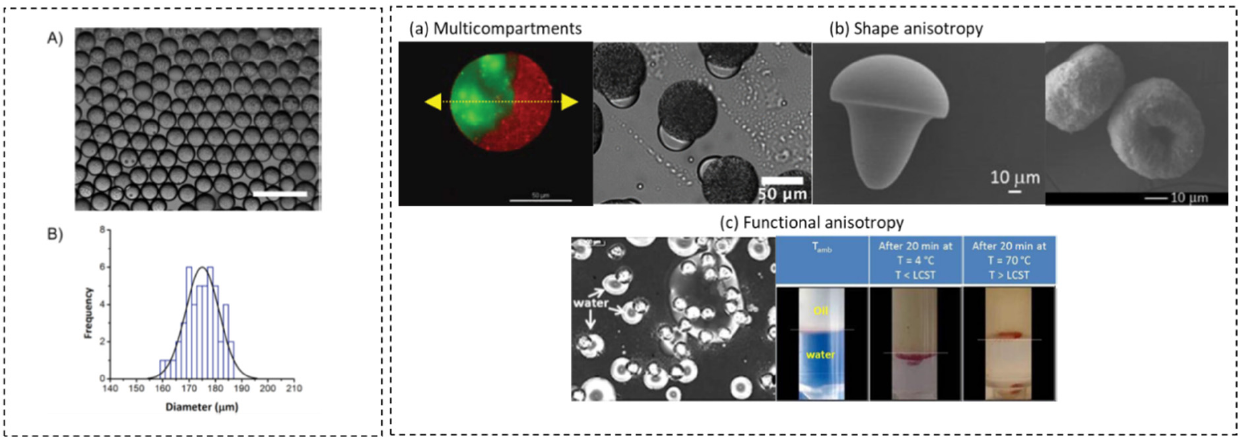
Figure 4. Control of the shape, size, and composition of microparticles and microcapsules produced by droplet microfluidics. ( A , B ) Size distribution of agarose-gelatin microgels obtained by the control of the flow rates in a flow-focusing device, adapted with permission from [43]. Copyright (2014) American Chemical Society. ( a ) Multicompartment and ( b ) anisotropic microparticles with Janus, mushroom, or doughnut morphologies and amphiphilic properties, adapted with permission from [45,46,49]. Copyright (2012) (2014) (2020) American Chemical Society. ( c ) Functional anisotropy as an amphiphilic property, reprinted from [47], with permission from Elsevier.